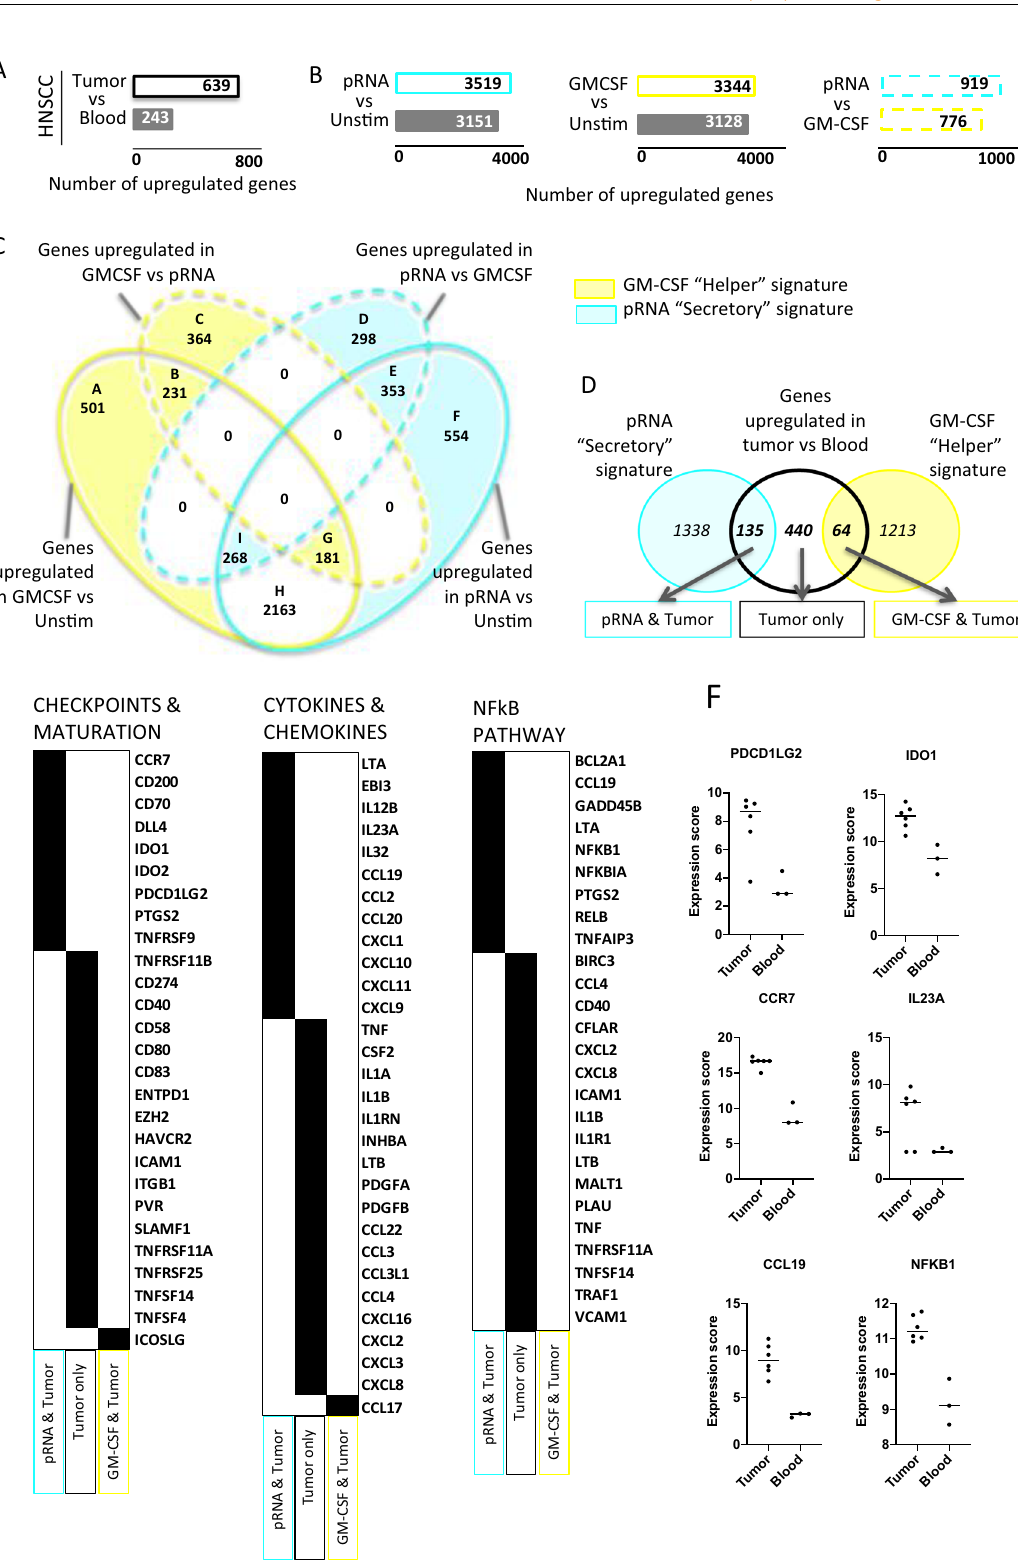
as previously shown 10,30 . None of the cDC clusters signi fi cantly expressed ADT CD103, as opposed to CD8 T cells and Mast cells (Supplementary Fig. 11A, B). All immune cell clusters were identi fi ed in both the tumor and juxtatumor samples, but the relative proportions of mmDC, pDC, B cells, Plasma cells, Neutrophils, and Mast cells were increased in the tumor samples whereas MMAC_PDL1 and